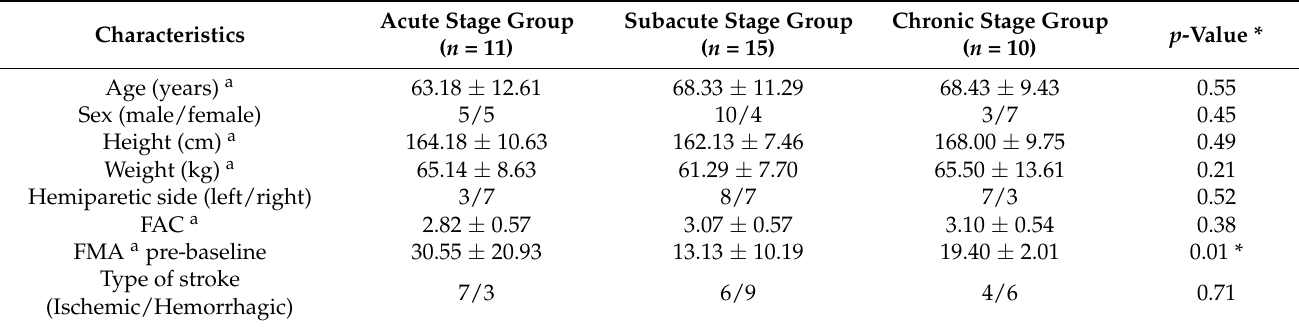
Table 1. Baseline demographic and clinical characteristics of the patients ( N = 36).